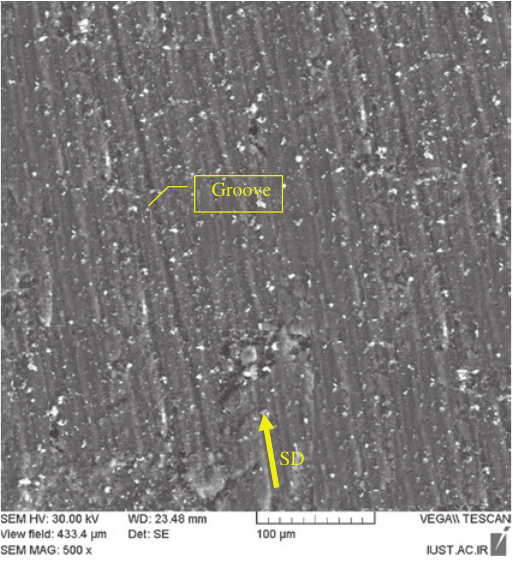
composite at peak p